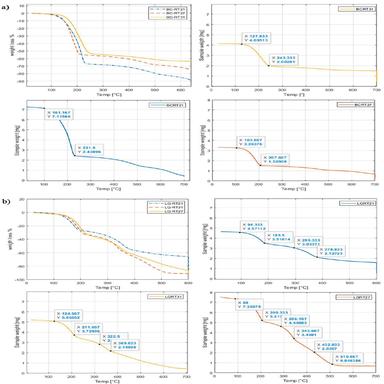
Percentage of weight loss and values of sample weight at the inflection points for a) biochar and b) lignin compounds.